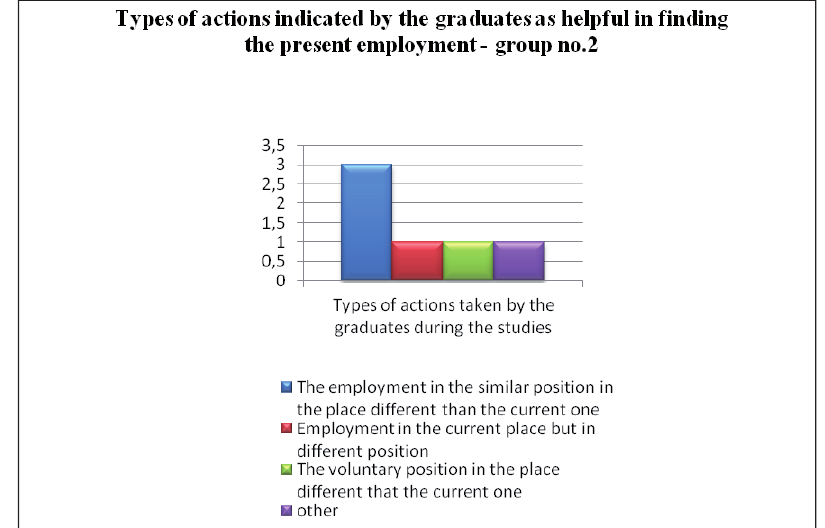
Fig. 10. The types of actions indicated as helpful in fi nding their current employment – group no.